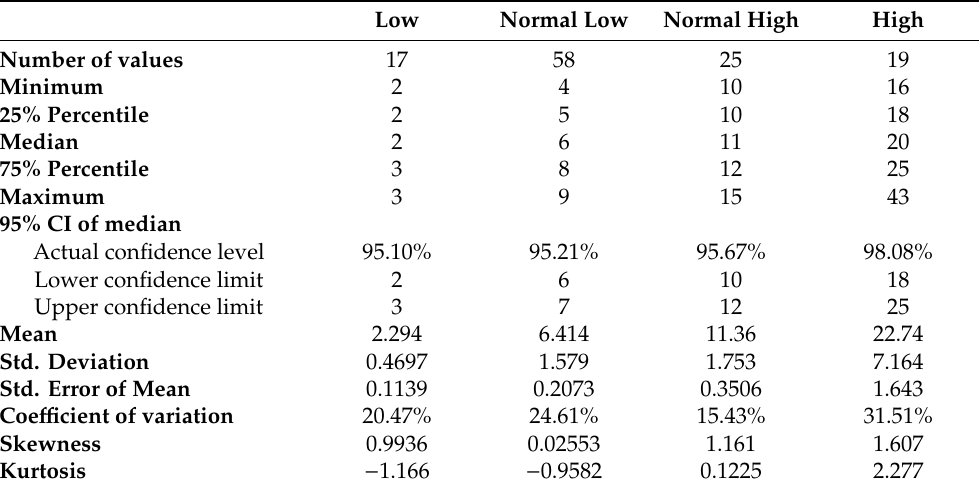
Table 2. Plasma vitamin B1